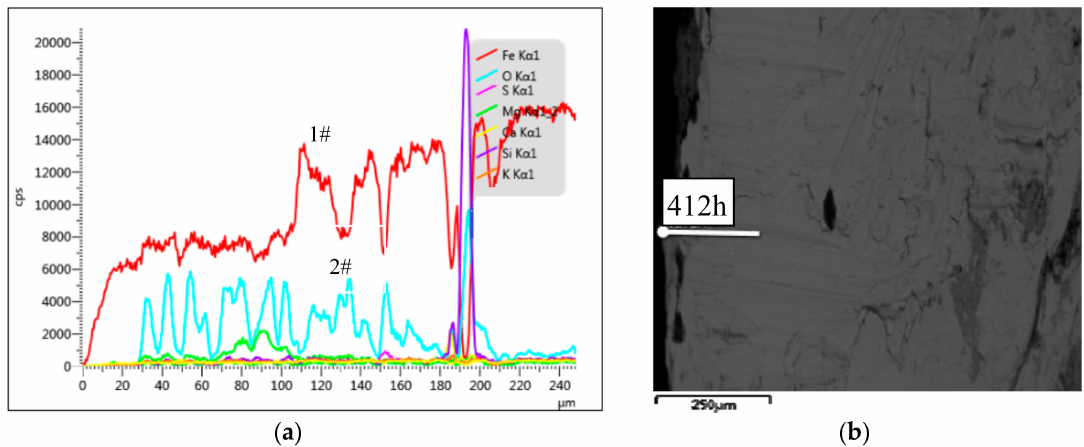
Figure 10. Group P30 line scan results. ( a ) The structure of steel corrosion products; ( b ) Micro-structure of corroded steel